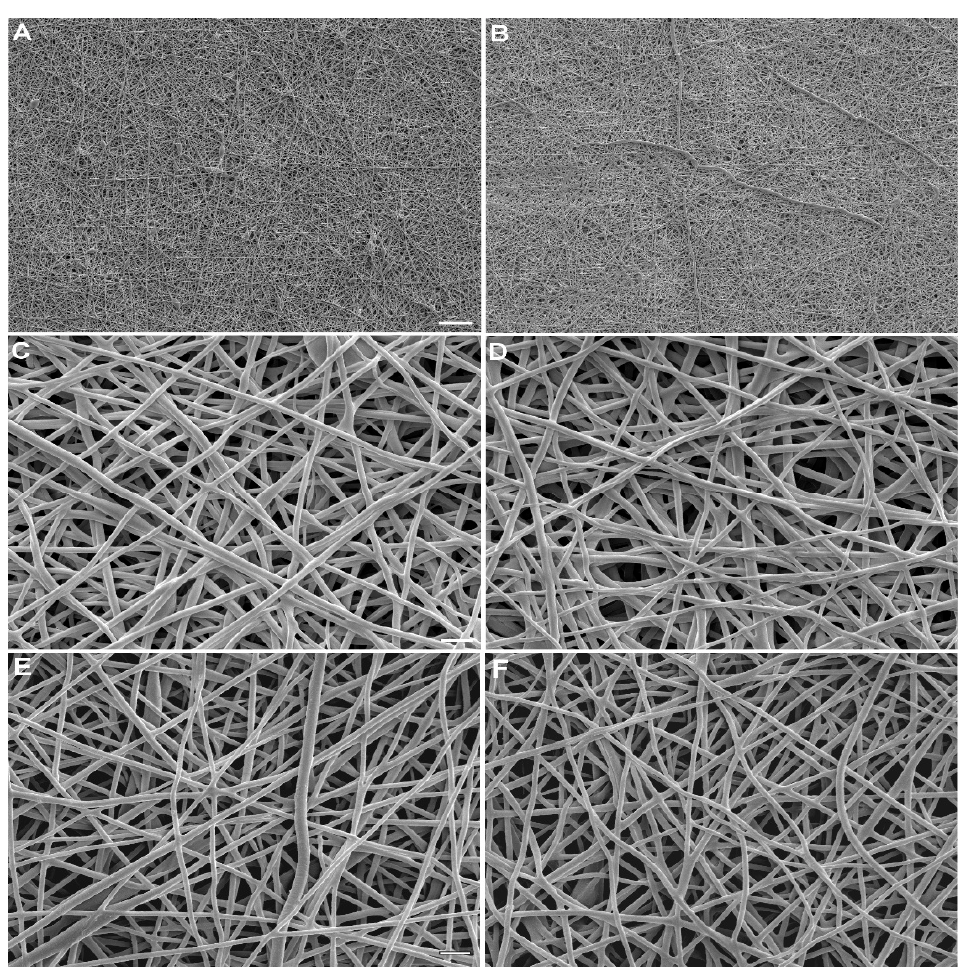
Figure 1. Representative scanning electron micrographs of electrospun 12% PCL-PLGA (1:1): ( A , C , E ) control scaffolds contained no KGN and ( B , D , F ) experimental scaffolds contained 16.7 mg of KGN per gram of polymer blend. ( A – D ) Meshes are shown as fabricated and ( E,F ) after 28 days of soaking in PBS. Scale bar: ( A , B ) 10 μ m; ( C – F ) 1 μ m.